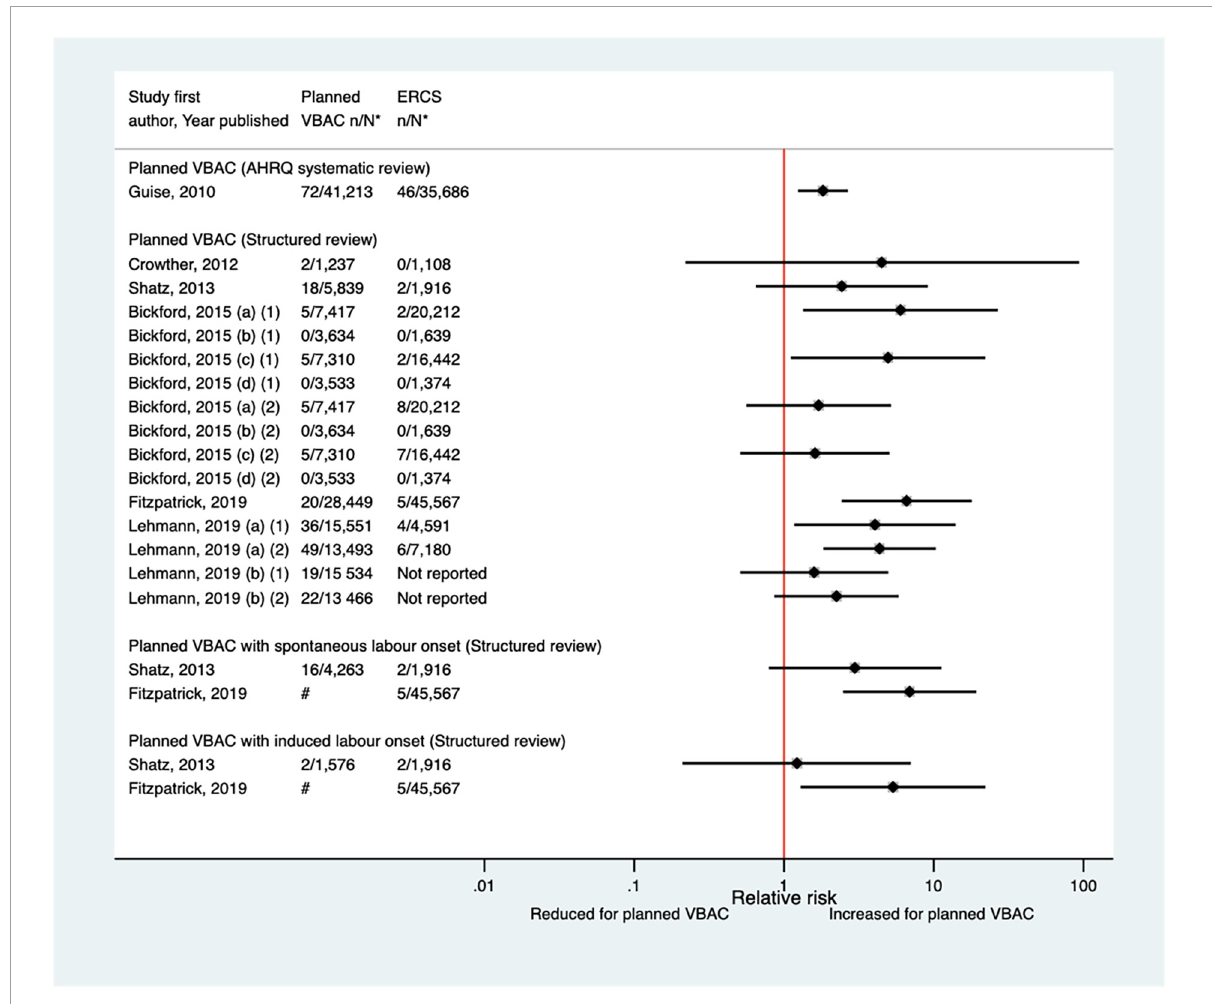
FIGURE7 Risk of perinatal mortality for planned VBAC vs. ERCS. ∗ n , number in group with the outcome; N , Total number in group; Bickford and Janssen (50) (a) risk in women with 1–2 prior CSs only, (b) risk in women with 1–2 prior CSs and ≥ 1 prior VB, (c) risk in women with 1 prior CS only, (d) risk in women with 1 prior CS and ≥ 1 prior VB, (1) outcome: intrapartum stillbirth or death at ≤ 7 days of birth, (2) outcome: intrapartum stillbirth or death up to 28 days of birth; Lehmann et al. (67) (a) outcome: intrapartum stillbirth, death within 28 days of birth, time of death unknown and pre-labor stillbirths delivered after 39 weeks’ gestation, (b) outcome: intrapartum stillbirth, death within 28 days of birth, and time of death unknown, (1) risk in “low-risk” women, (2) risk in “high-risk” women. # Numbers have not been shown to protect against potential disclosure risks. AHRQ, Agency for Healthcare Research and quality; CS, cesarean section; ERCS, elective repeat cesarean section; VBAC, vaginal birth after previous cesarean; VB, vaginal